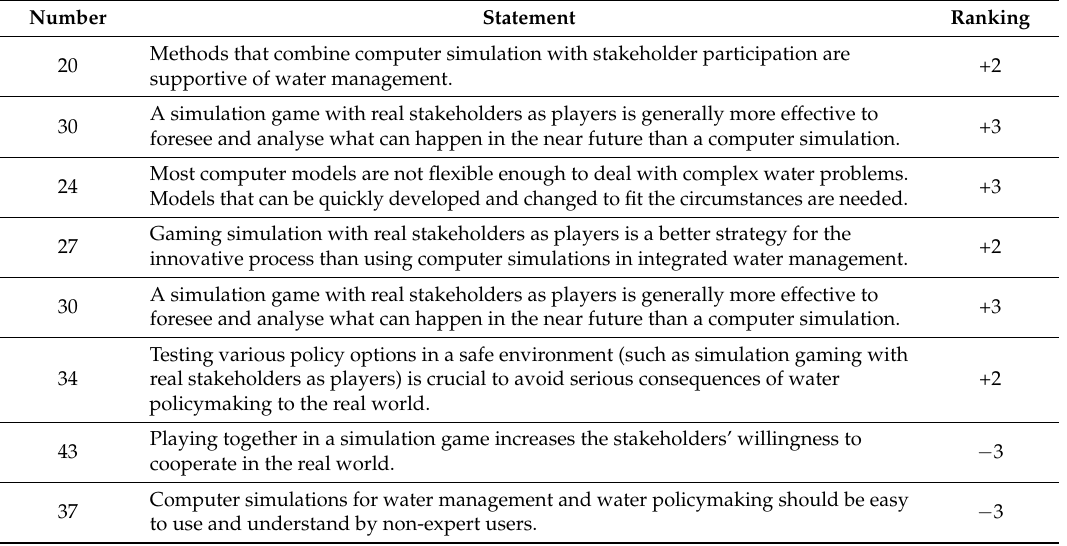
Table 6. Distinguished statements about MSG in frame